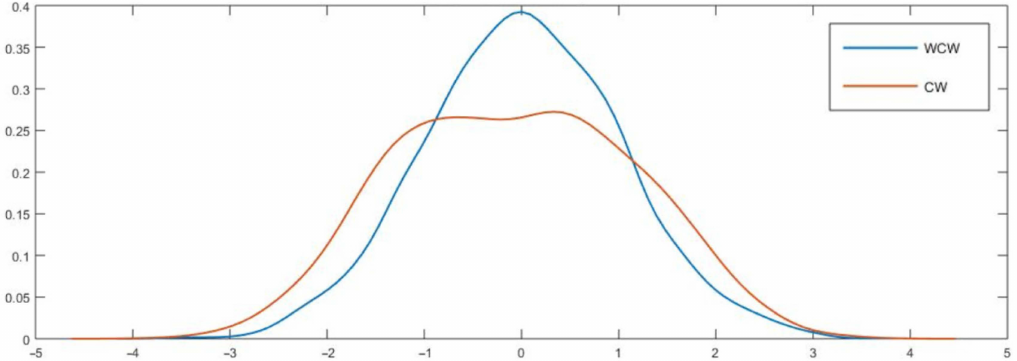
Figure 2. Kernel densities of CW and WCW under the null hypothesis, DGP2, h = 21. Note: See notes in Figure 1.